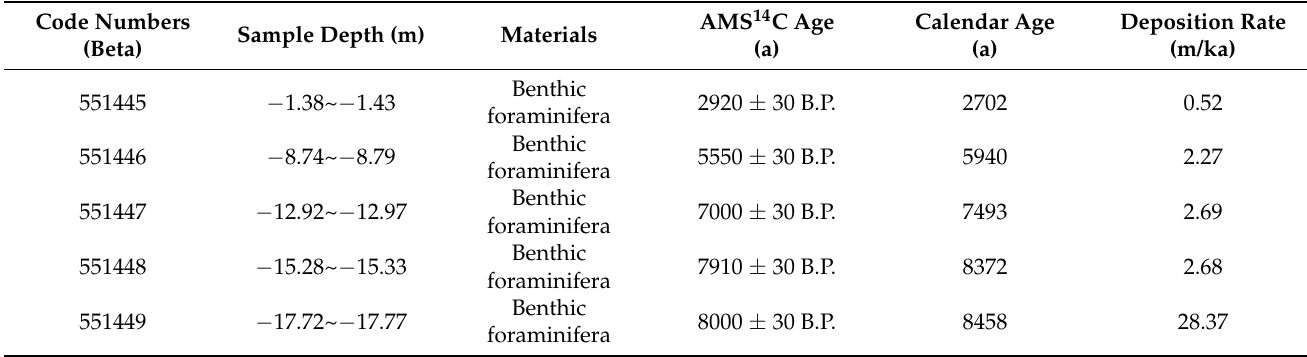
Table 1. Age framework and deposition rate list.